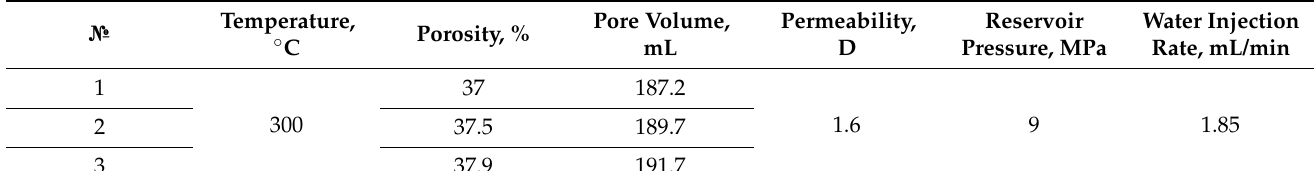
Table 7. Conditions of experiments.